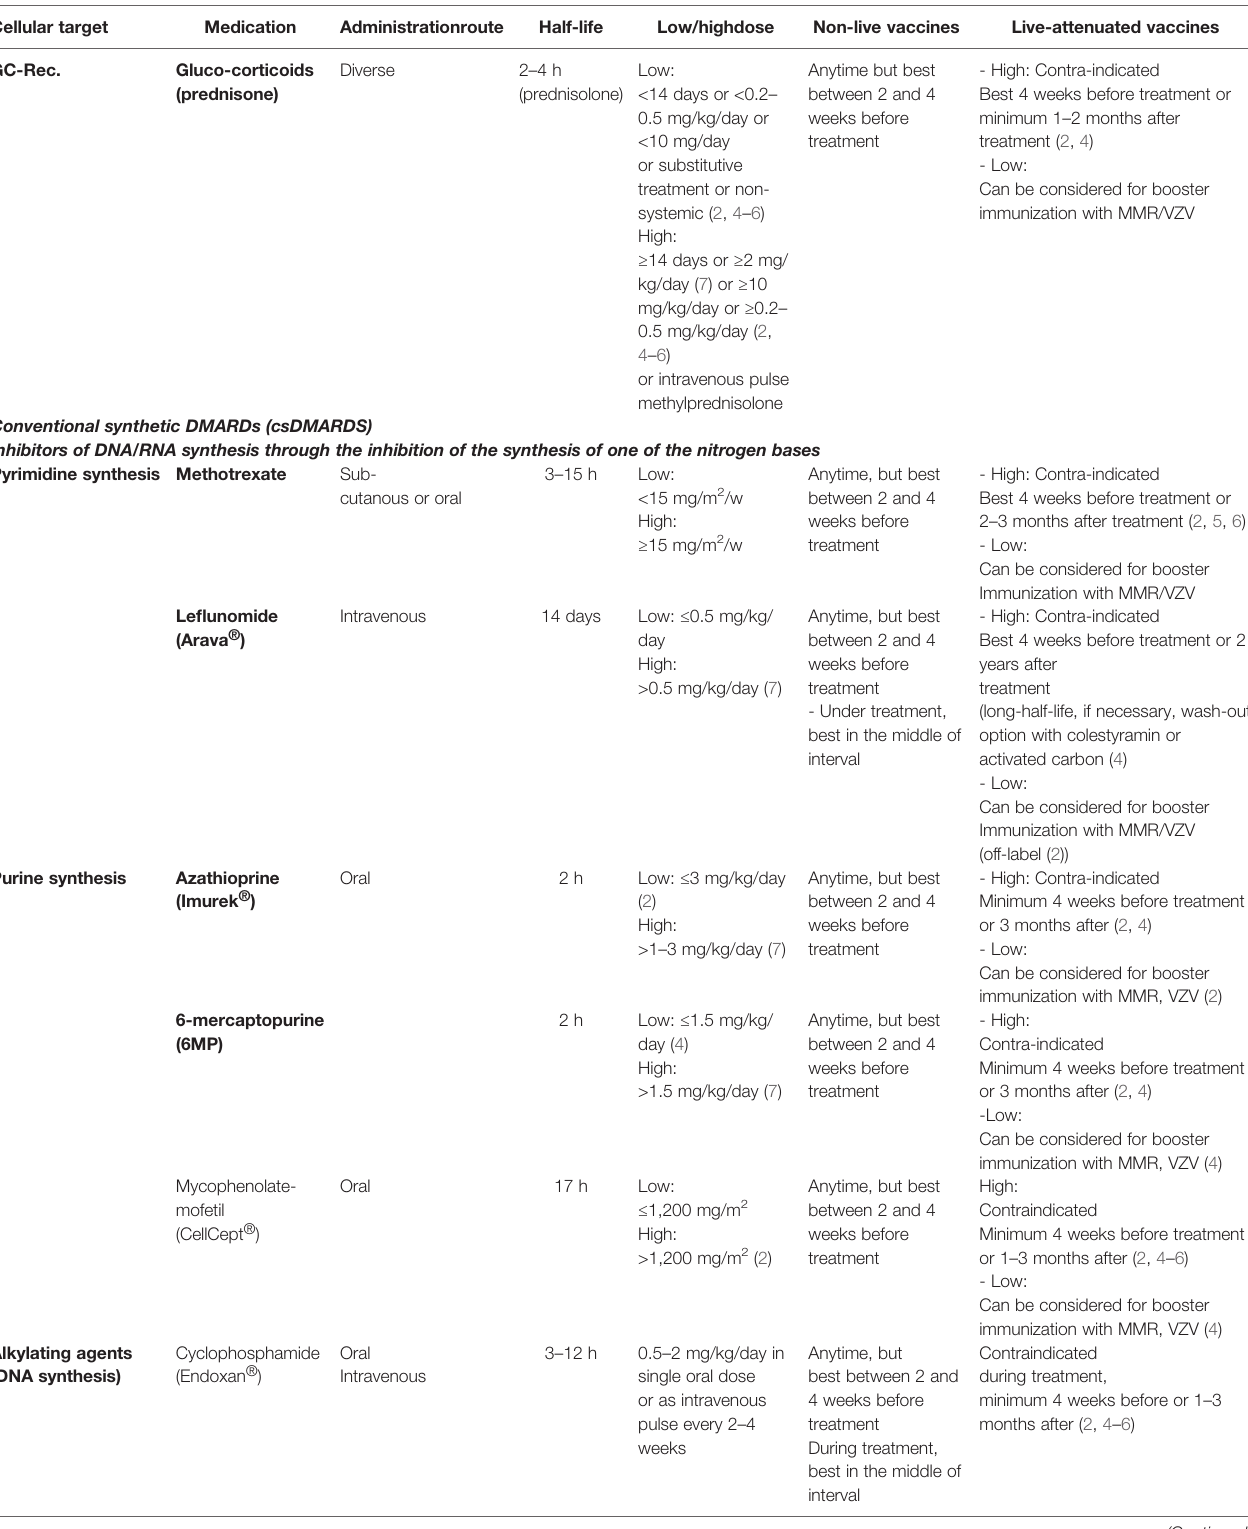
TABLE 1 | List of immunosuppressive agents and current recommendations concerning vaccination [adapted from (2, 3)]. Cellular target